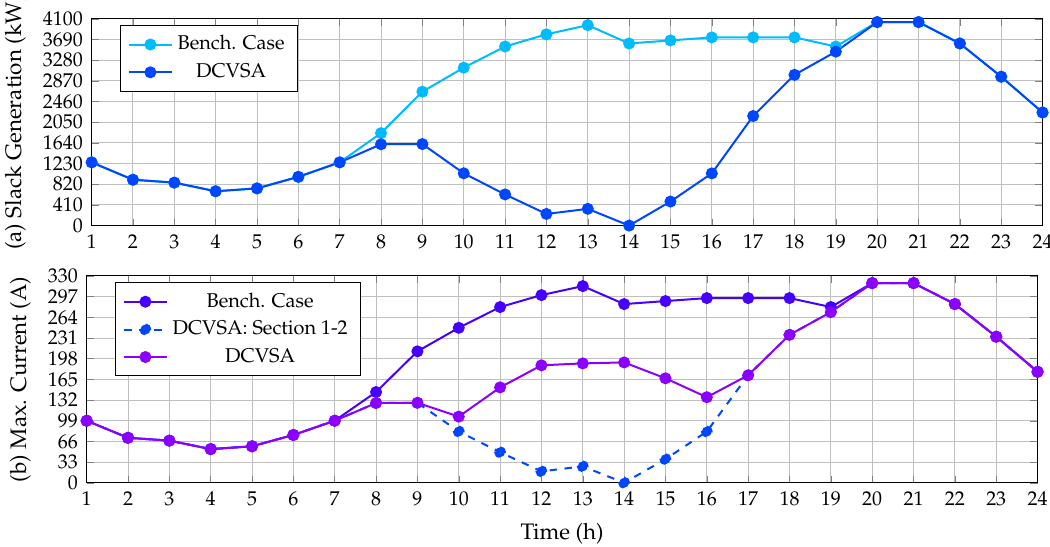
Figure 12. Impact of the PV inclusion in the DC version of the IEEE 69-bus system: ( a ) power injections in the slack source and ( b ) maximum current performance.